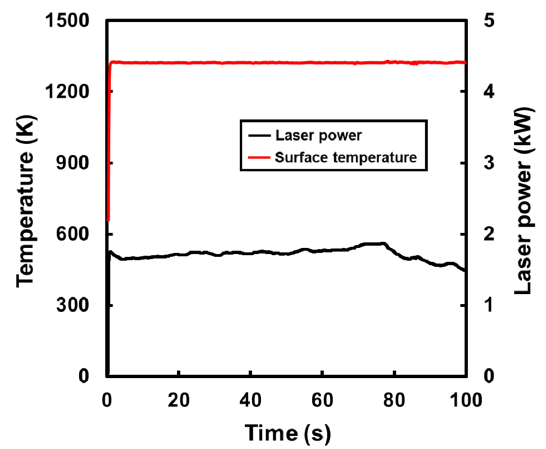
Figure 10. Trends of laser power and surface temperature during laser heat treatment of the clad metal (set temperature at surface: 1323 K).